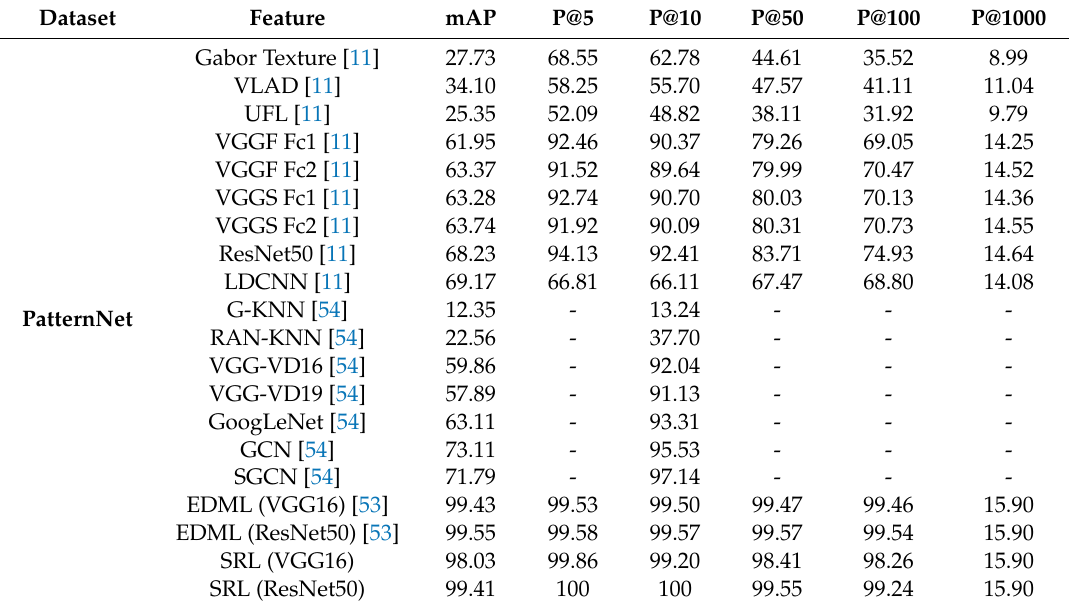
Table 3. Evaluation results on the PatternNet and UCMD database comparing with the state-of-the-art